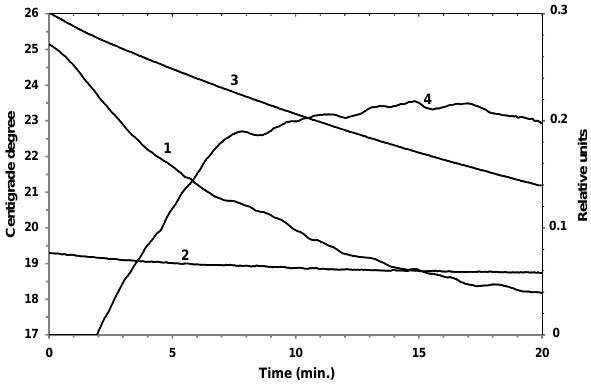
Fig. 1. Typical changes with time of the BCC parameters during convective cloud modeling. Air temperature and the wall chamber temperature variations (curves 1, 2, respectively, left scale), a rela- tive excess of air pressure in the chamber (Pc-Po)/Po where Pc and Po are the chamber and outside pressures, respectively (curve 3, Figure 1. Typical changes with time of the BCC parameters during convective cloud 2 right scale), the coefficient of light attenuation in the cloud medium at the 0.63µm wavelength (4,m − 1 , right scale). The time count modeling. 3 begins at the moment of the beginning of the pressure